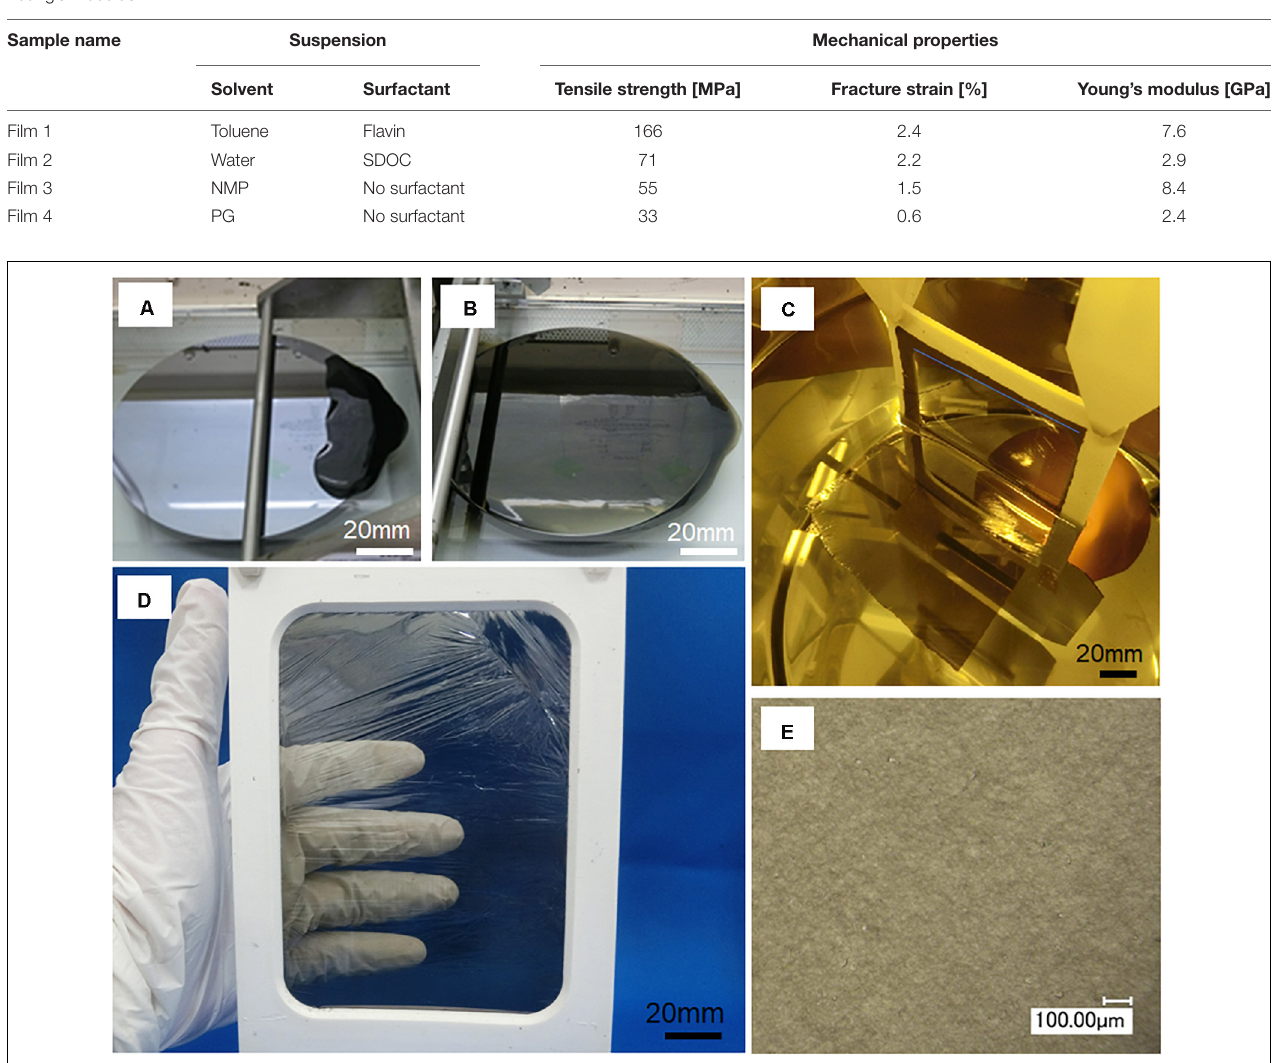
TABLE 1 | Four types of CNT films prepared using four types of suspensions and their mechanical properties by tensile test – tensile strength, fracture strain, and Young’s modulus.